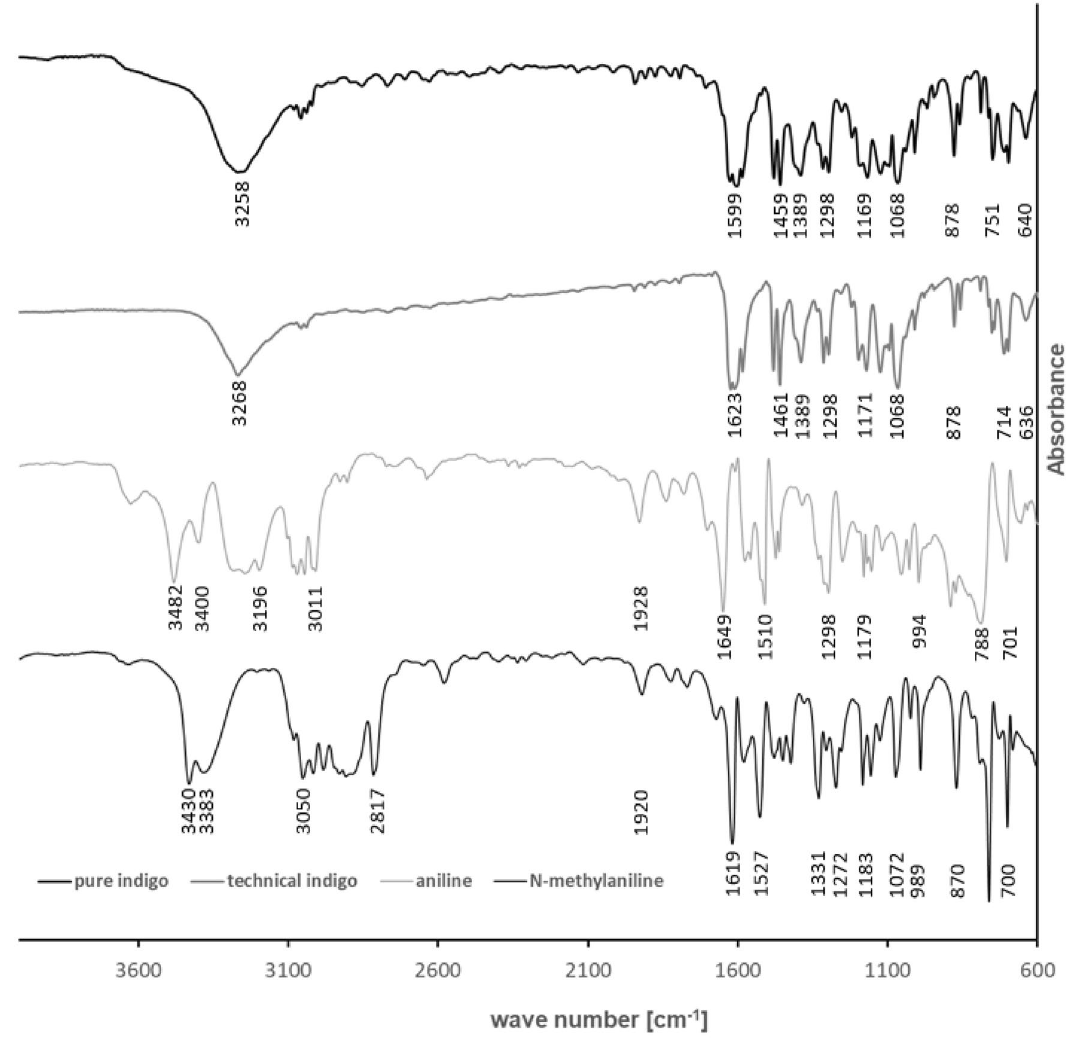
Figure 6. IR spectra of indigo pure, technical indigo (0.63% aniline and 0.30% N-methylaniline), aniline and N-methylaniline. All IR-spectra were measured in the reflection mode. Aniline has a N–H stretching vibration at 3482 cm −1 and N-methylaniline at 3431 cm −1 , indigo does not have this vibration at the corresponding wave